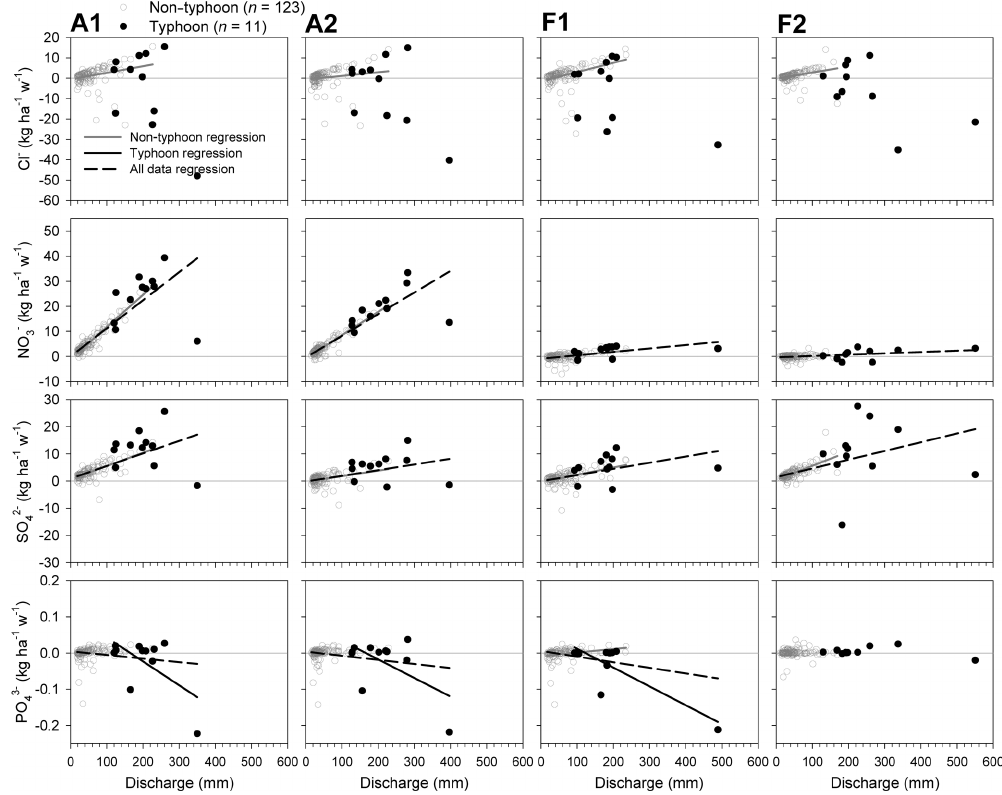
Figure 6. Relationship between stream discharge and nutrient budget (stream output–precipitation input) of anions (Cl − , NO − ) . The grey, black, and dash lines indicate significant linear regressions between discharge and ions budgets for non-typhoon, typhoon, PO 3 − 4 and all data, respectively. Please refer to Table S2 for the regression models and R 2